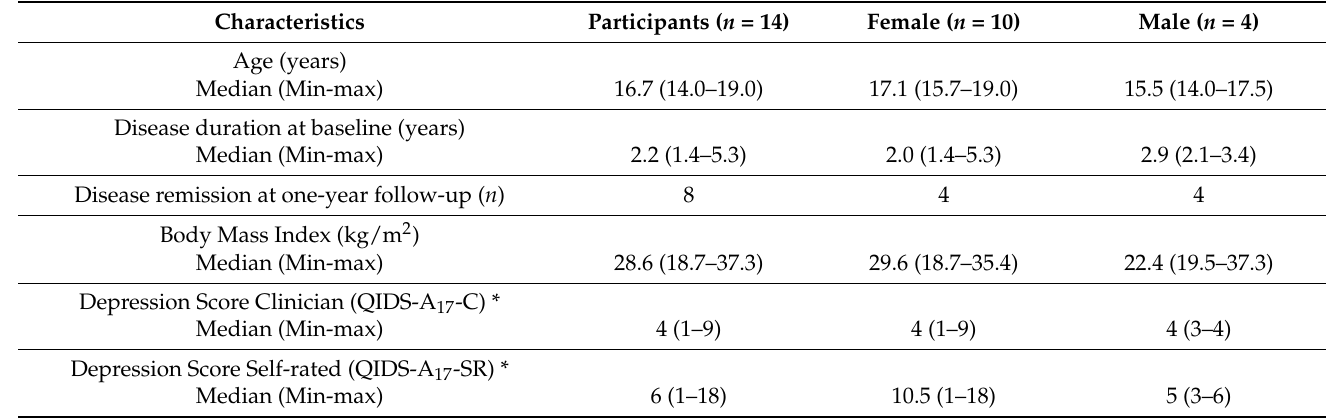
Table 1. Participant characteristics at one-year follow-up, after participating in group-based exercise intervention for depression ( n =